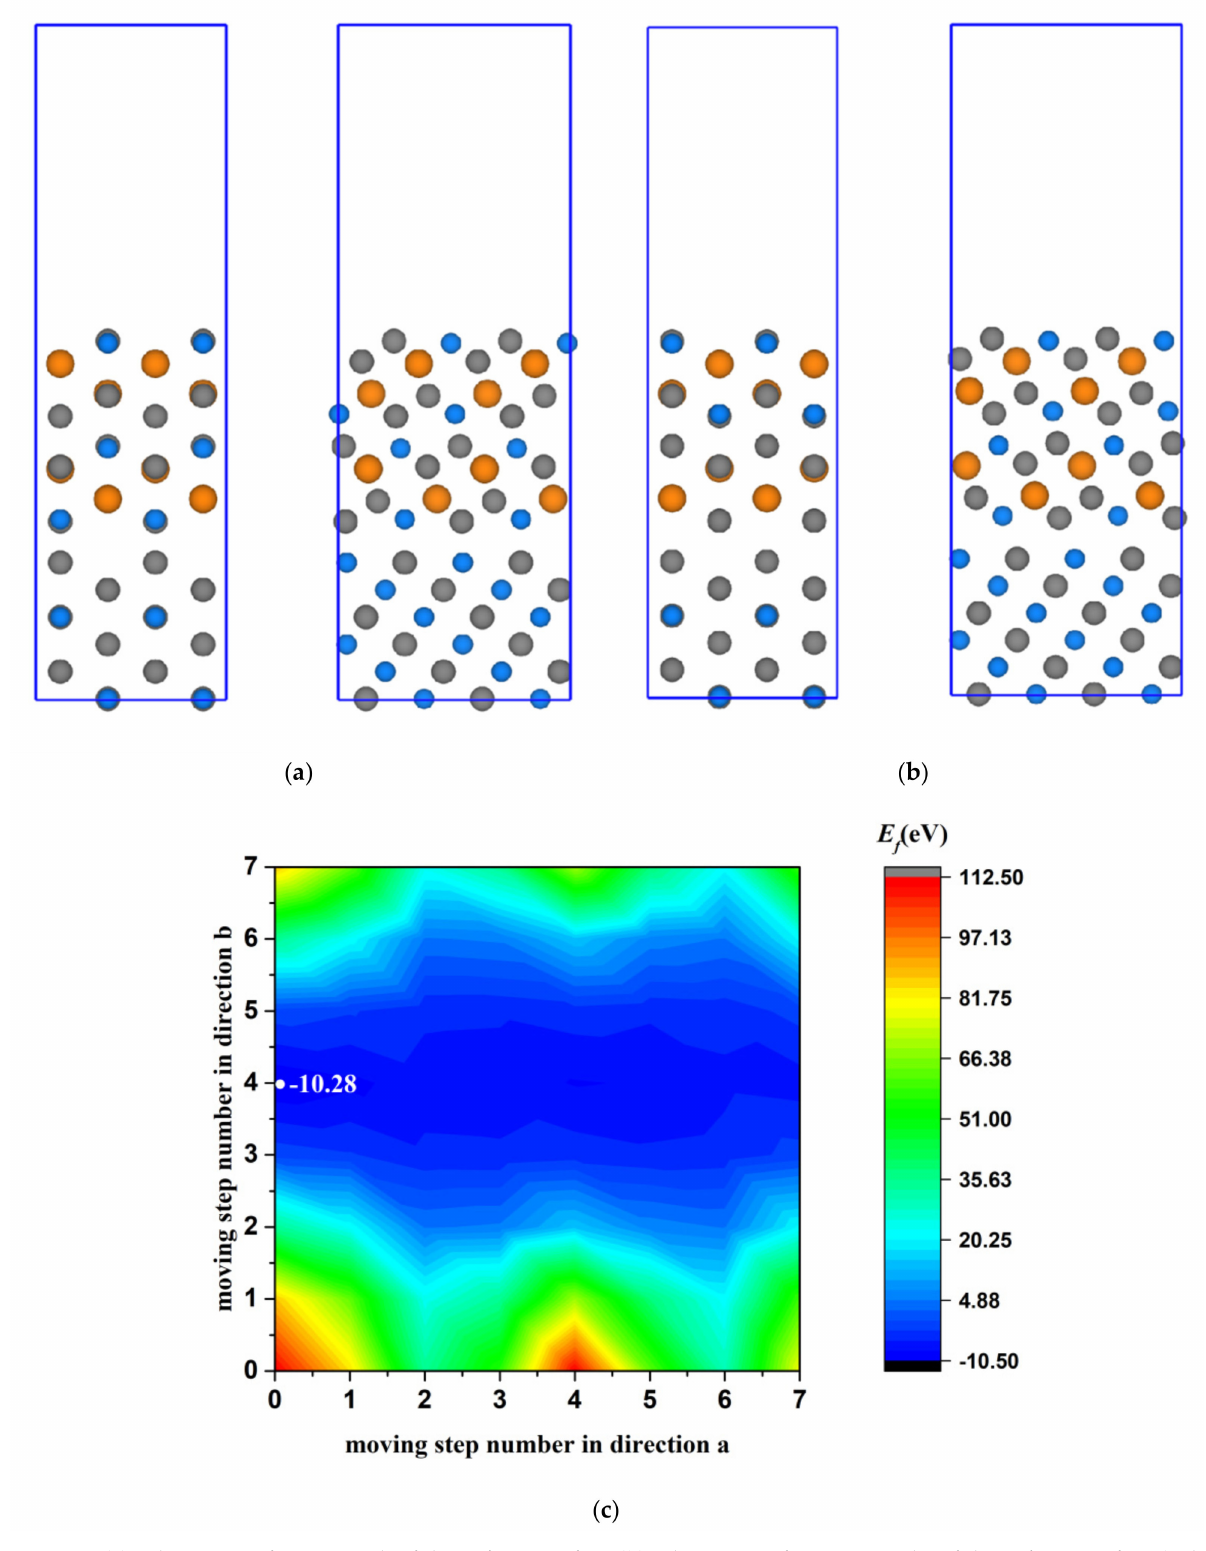
Figure 4. ( a ) Schematics of “OT” stack of the O/B2 interface ( b ) schematics of “HCP” stacks of the O/B2 interface (side views), ( c ) formation energy surface against the relative positions between O and B2 phases. Gray, orange, and blue balls denote Ti, Nb, and Al atoms,